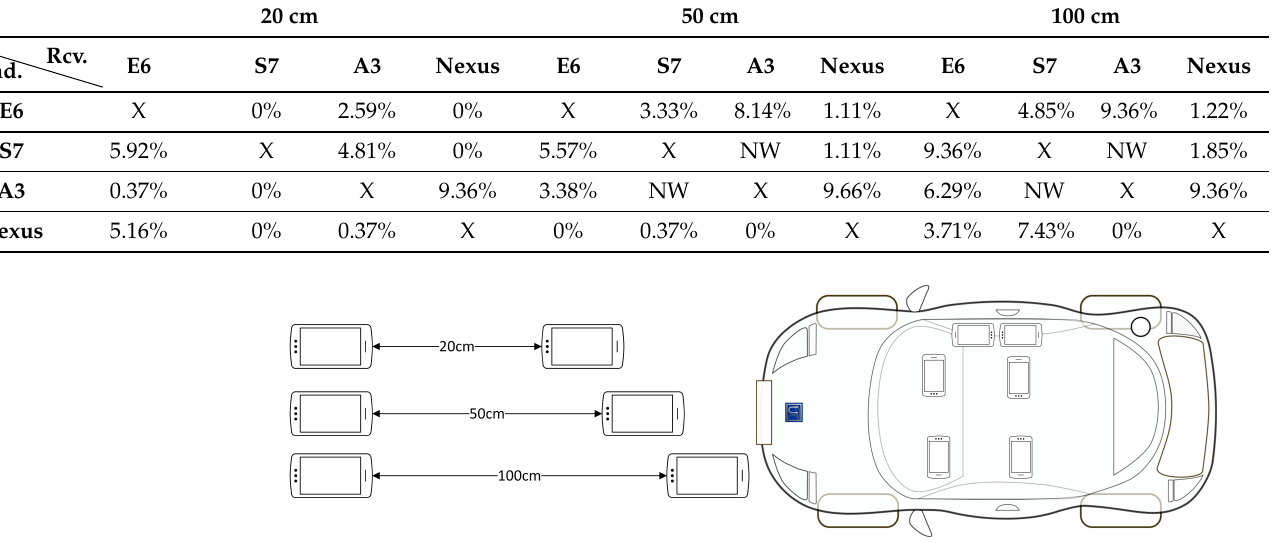
Figure 11. Distance between phones at indoor measurements ( left ) and in-vehicle measure- ments ( right ).